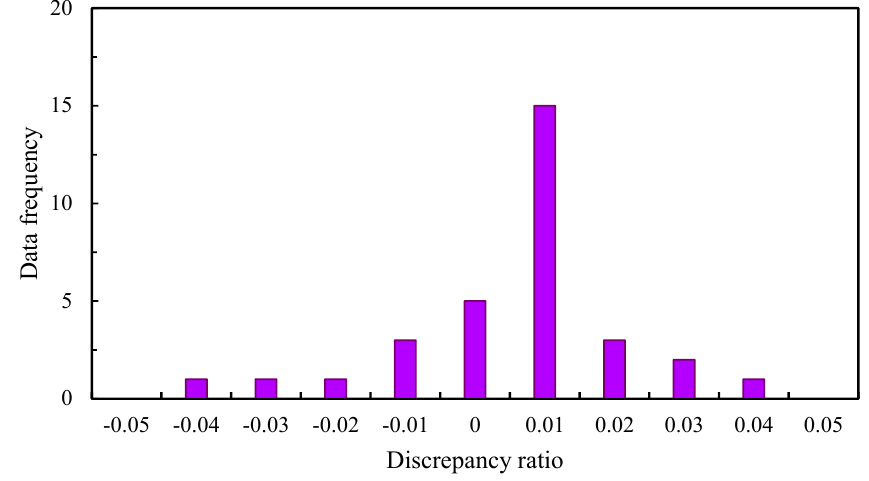
Figure 7. Variation of present data frequency with discrepancy ratio.